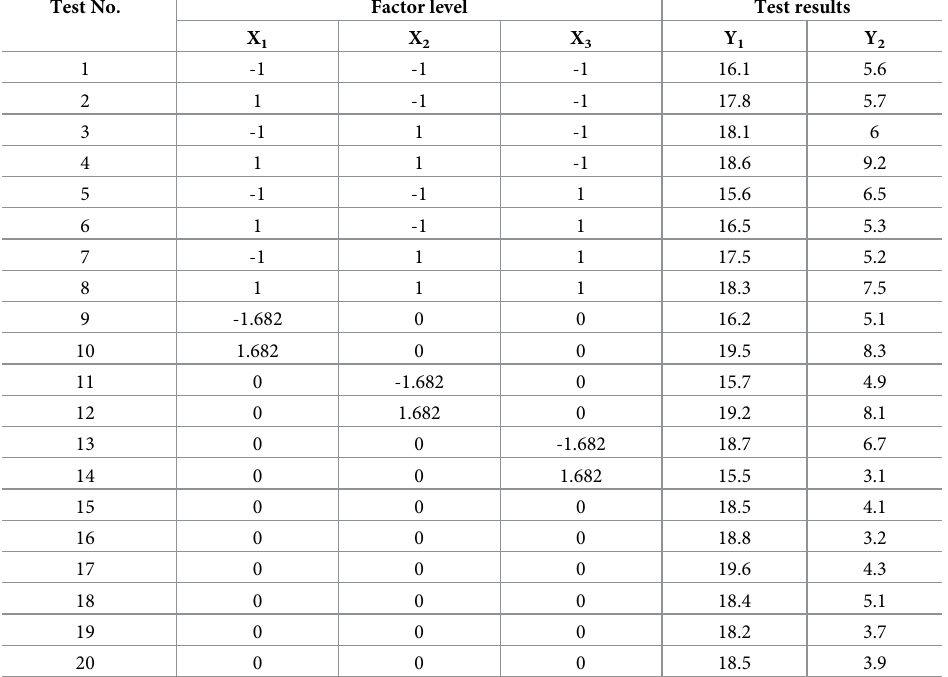
Table 4. Experimental design scheme and test results. Test